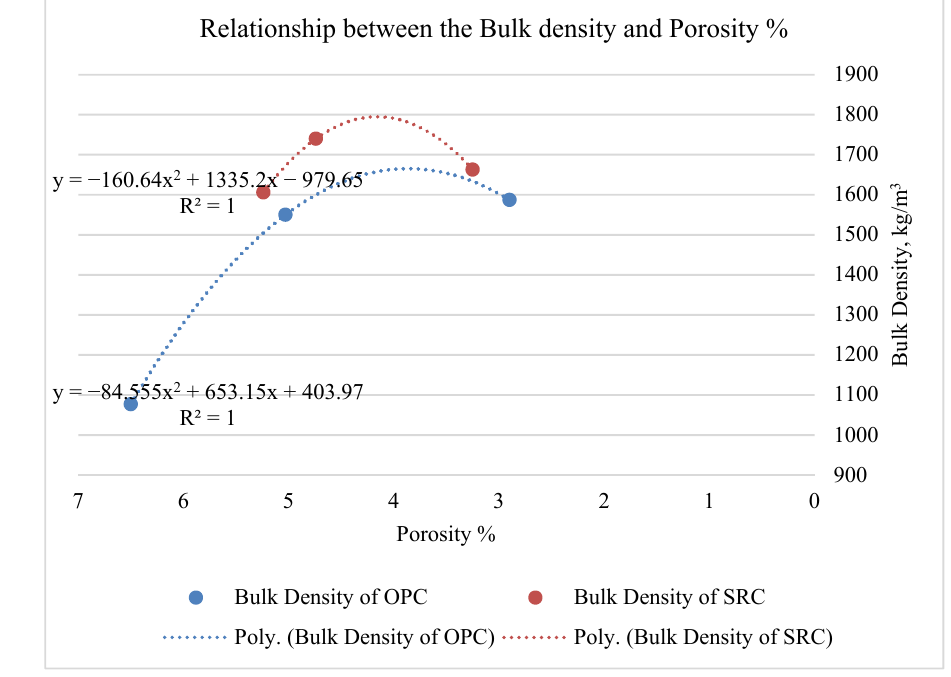
Figure 11. Differences between the values of OPC and SRC for bulk density. Based on the relationships shown in Figure 11, the differences between the values of OPC and SRC are significantly increased, by 49% for bulk density, for 100% WRT. The porosity ratio varies by nearly 19%, and the variations between the types (OPC and SRC) for other samples are between 7% and 10% for both 75% and 50% WRT, with variations in the porosity ratio between 35% and 63%. By comparison, with increasing WRT, the porosity ratio and the void ratio increase, implying that the concrete permeability increases with an increase in porosity and a decrease in density. Additionally, porosity is the primary factor that governs the strength of brittle materials. As the capillary porosity decreases, with OPC resulting in a higher porosity ratio than SRC. In general, the porosity is increased with increasing WRT content. As the porosity ratio is higher with OPC than with SRC,